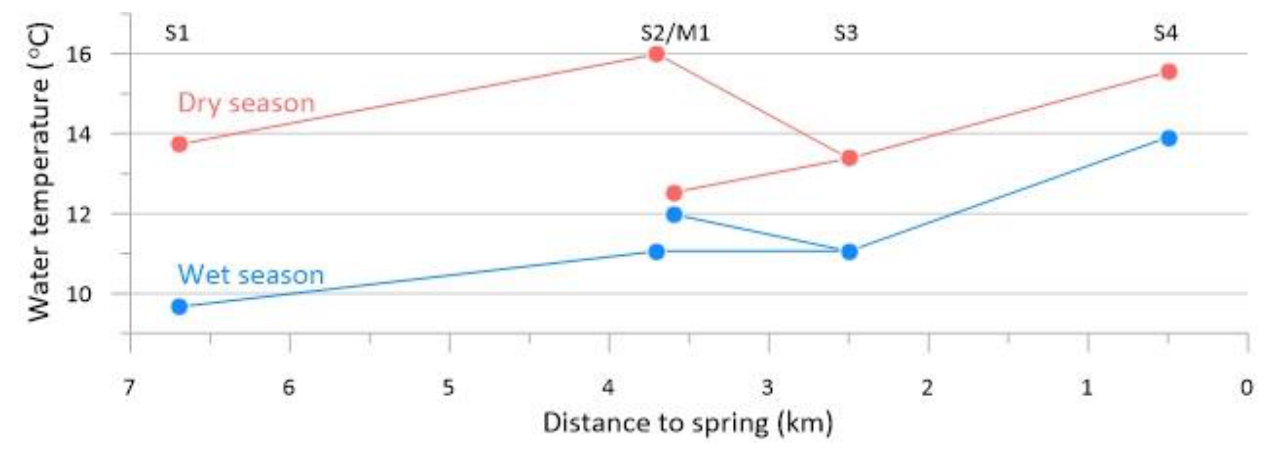
Figure 4. The graph presents typical dry and wet season input temperature (S1 and M1) and temperature evolution along the cave path in Maaras represented by the temperature measurements on 1 November 2020 and 1 March 2021, respectively.